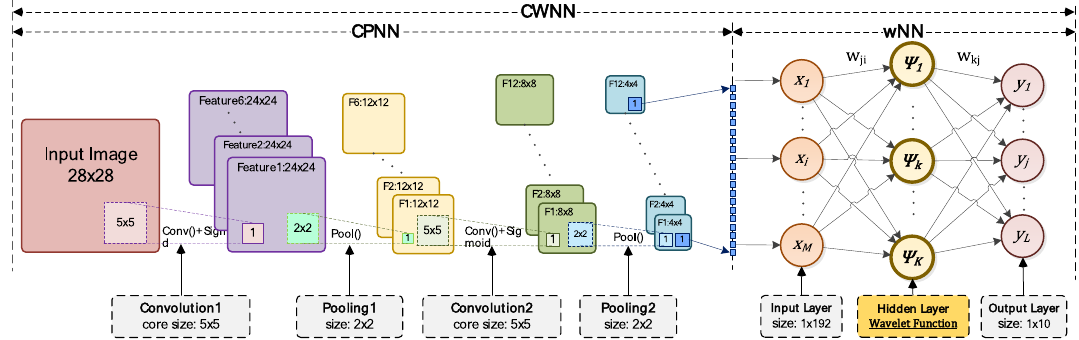
Figure 3. Structure of CWNN. CWNN is composed of CNN and WNN. CNN consists the convolution layer and the pooling layer. The fully connected neural network (FCNN) of CNN is replaced by